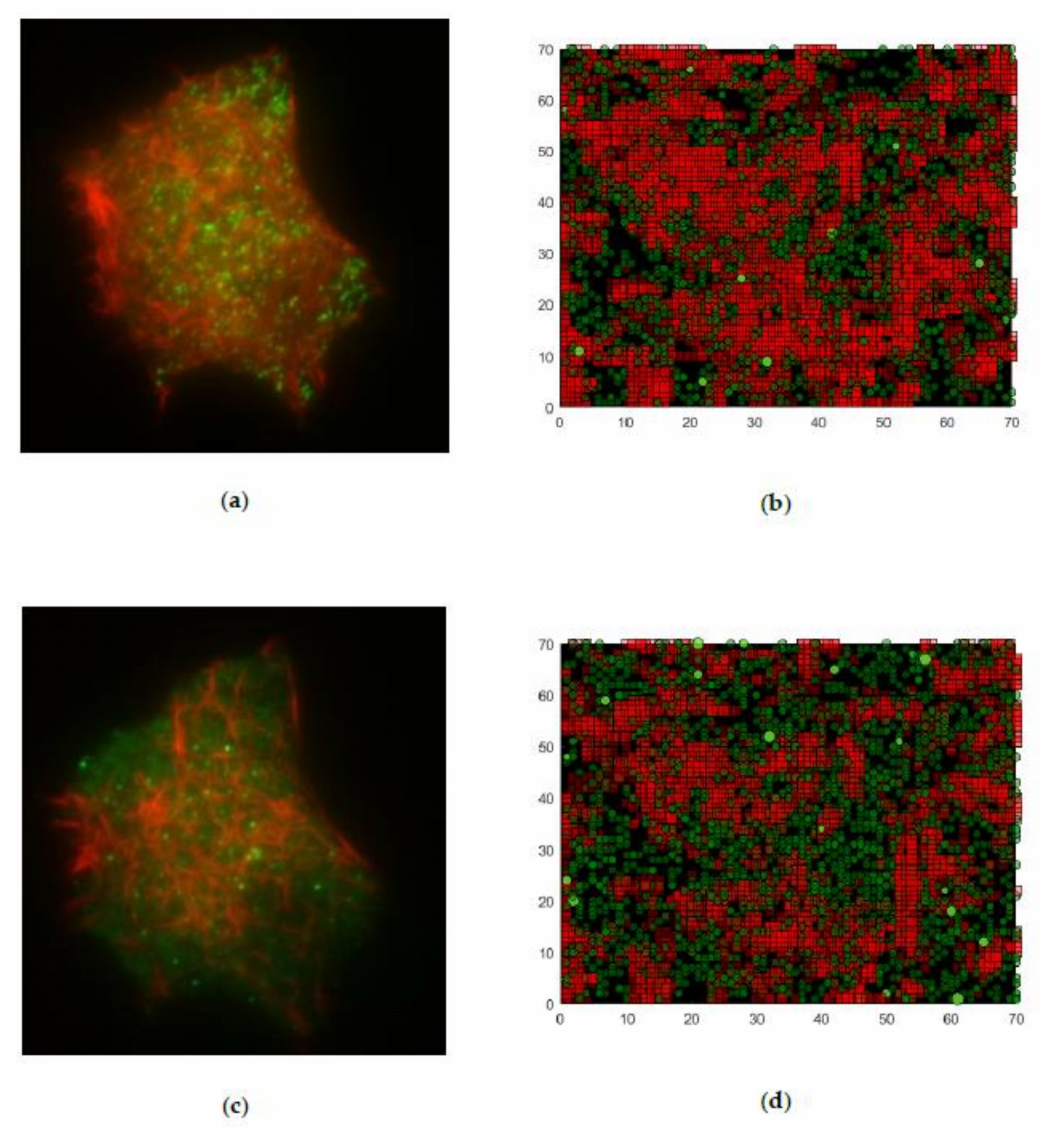
Figure 20. comparison between TIRF microscope pictures (left) and simulation results (right) with varying actin networks due to the supply of latrunculin, ( a ) TIRF picture of a cell before supply of latrunculin, ( b ) simulated configuration of the ten layers nearest to the boundary for network #1, ( c ) TIRF picture of a cell after supply of latrunculin, ( d ) simulated configuration of the ten layers nearest to the boundary for network